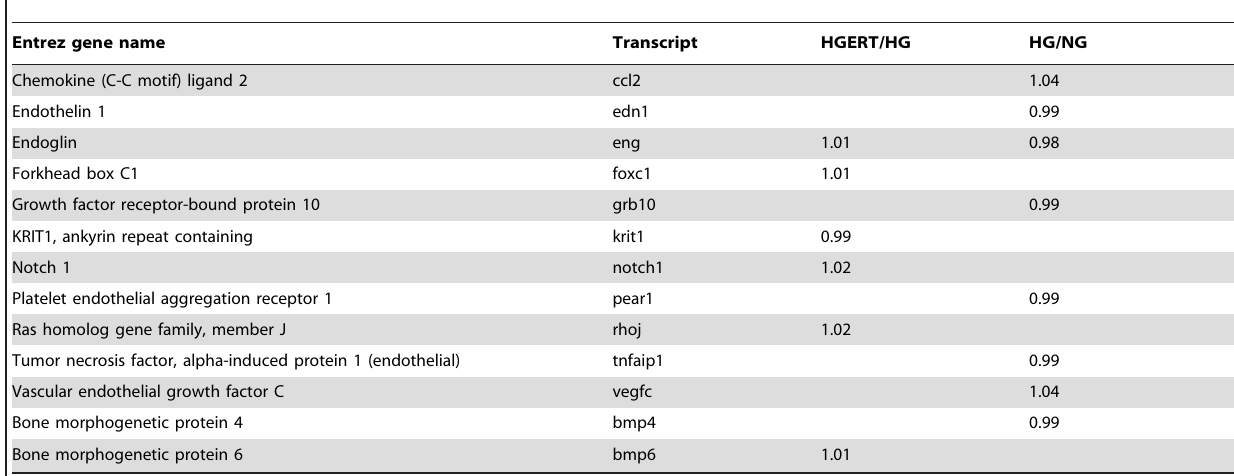
Table 1. Altered transcripts with a link to endothelial function.